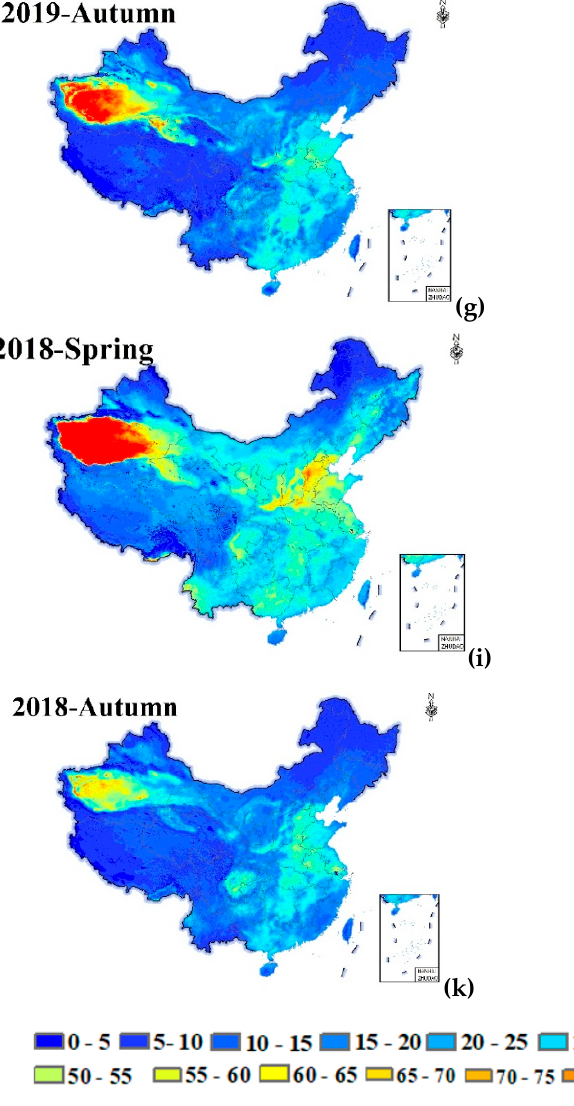
Figure 7. Season average distribution of PM 2.5 concentration. (a)-(d), (e)-(h), and (i)-(l) represent spring, summer, autumn, and winter in 2020, 2019, and 2018.